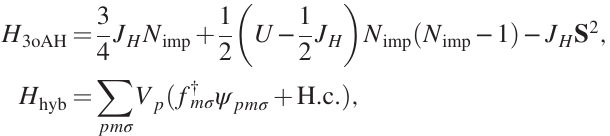
FIG. 7. Imaginary part of the impurity spin and orbital susceptibilities for the Anderson-Kondo model, with U ¼ 5 , J H ¼ 1 , Γ ¼ 0 . 1 , I 0 , and J K J K 0 (pure Anderson-Hund model) to (d) − J 0 ¼ 0 , 0 varying from (a) 0 ¼ 0 ¼ orbital screening, T and T , are pushed apart with increasing − J 0 ¼ K 0 sp orb